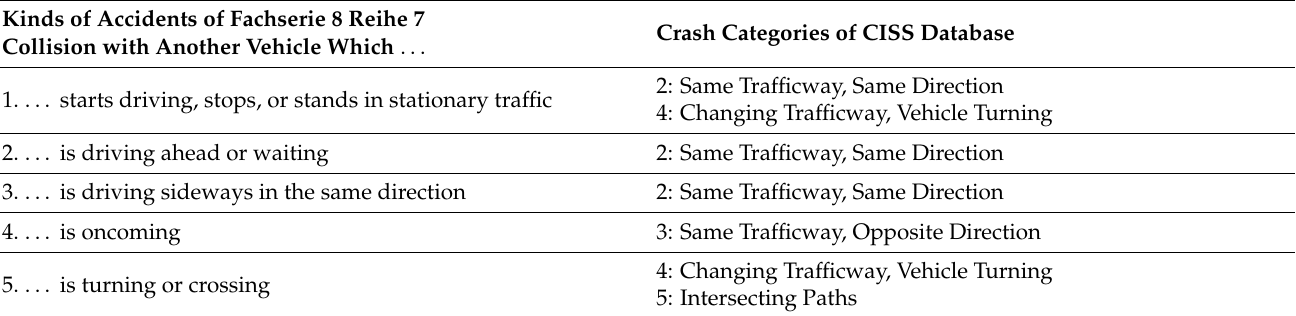
Table 1. Linking of kinds of accidents according to [15] and crash categories according to [16,17]. Kinds of Accidents of Fachserie 8 Reihe 7 Collision with Another Vehicle Which . .